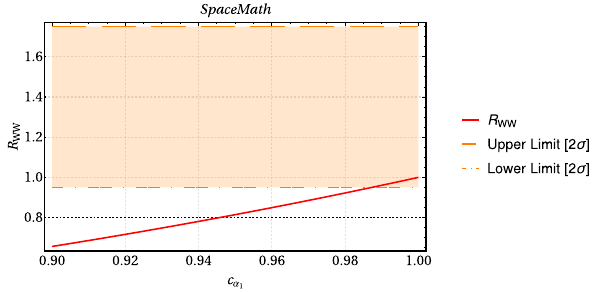
. The dark area (orange online) rep- 1